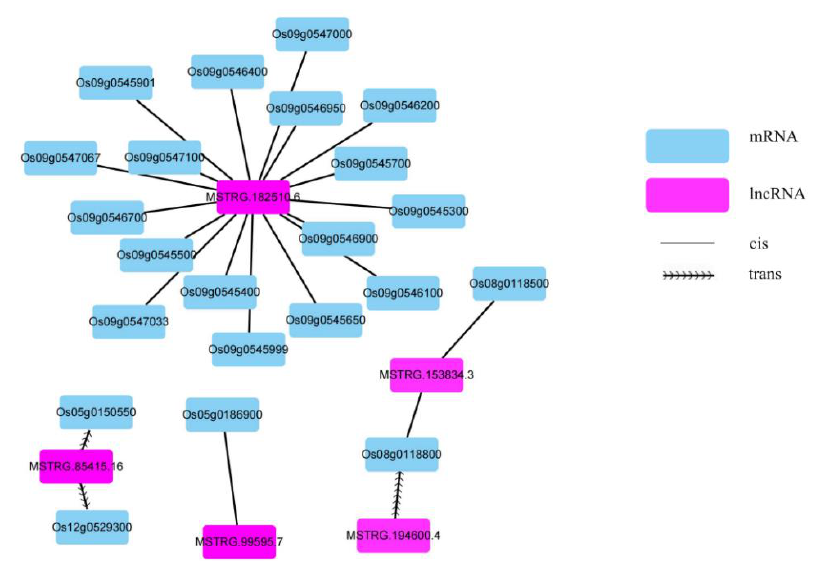
Figure 7. The regulatory network connecting lncRNAs and auxin-activated signaling pathway mRNAs. The purple diamonds represent lncRNAs, and the blue diamonds represent mRNAs. The wavy lines represent trans relationships, and the straight lines represent cis